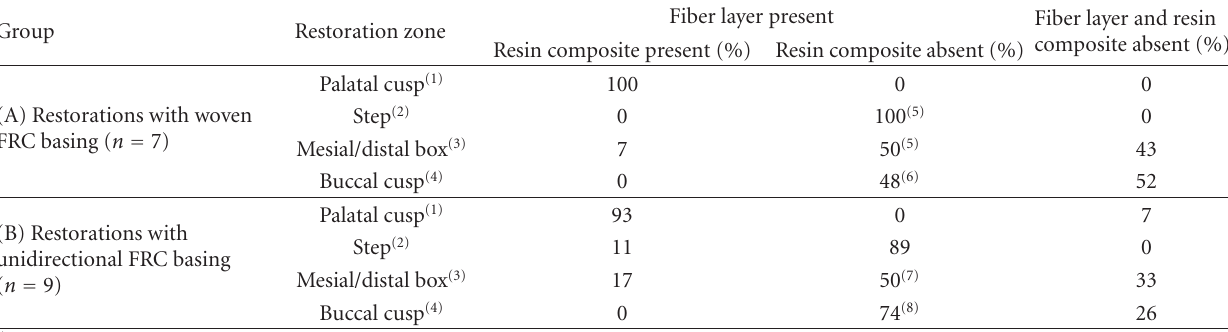
Table 1: Condition of the specimens before repair.